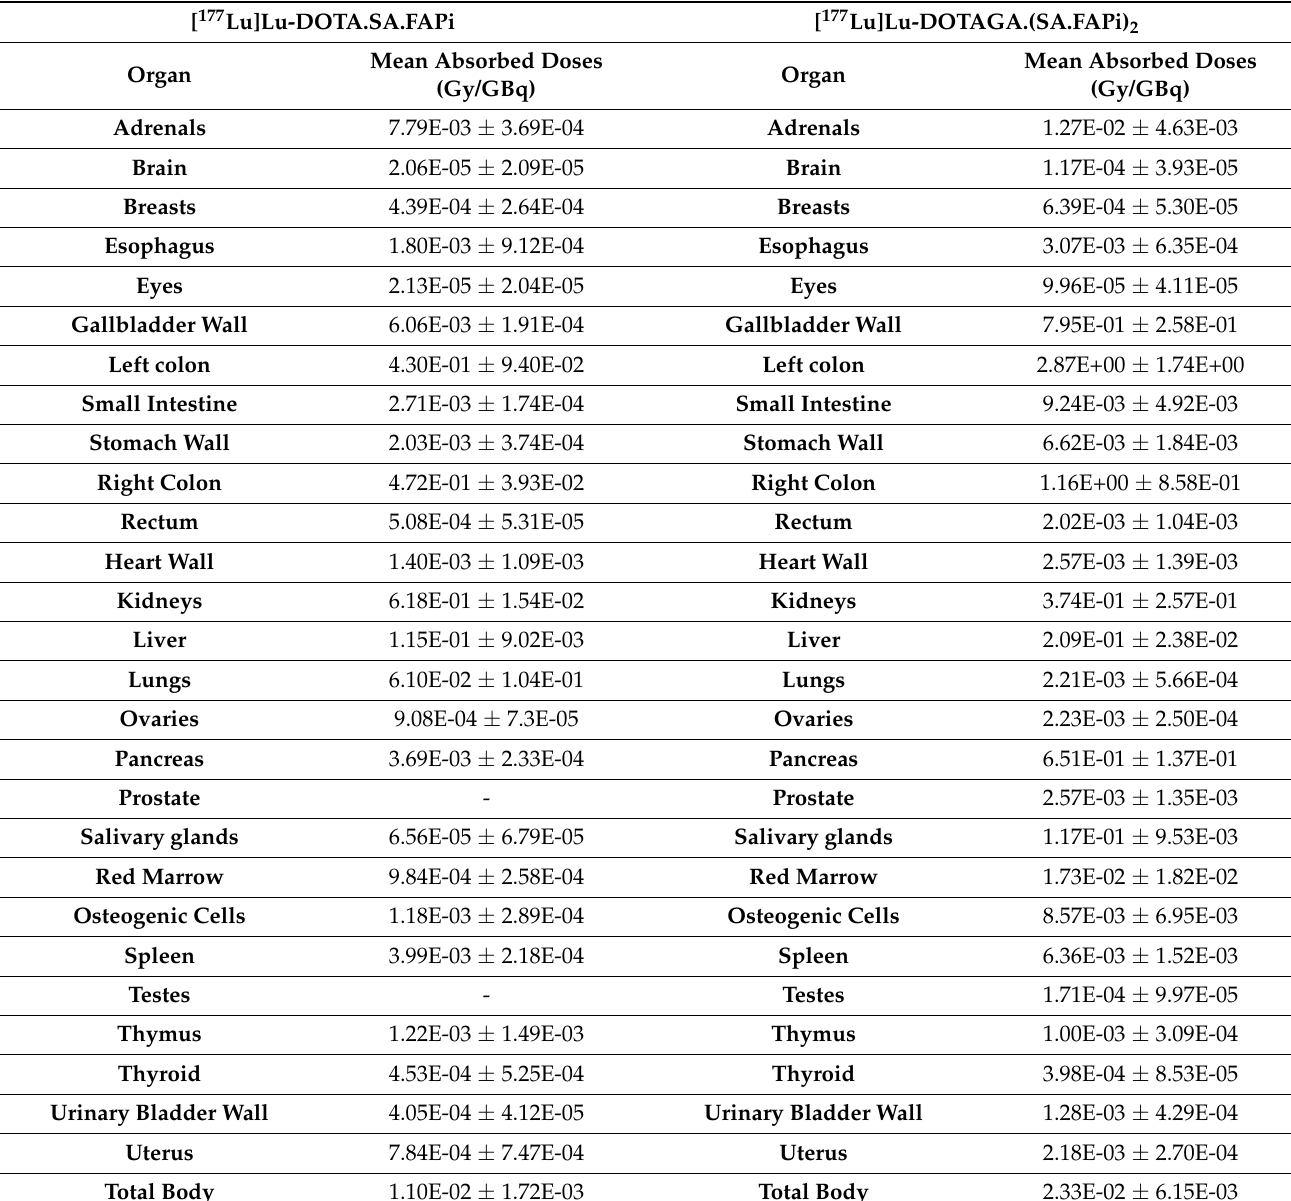
Table 4. Absorbed dose estimates of [ 177 Lu]Lu-DOTA.SA.FAPi and [ 177 Lu]Lu-DOTAGA.(SA.FAPi)